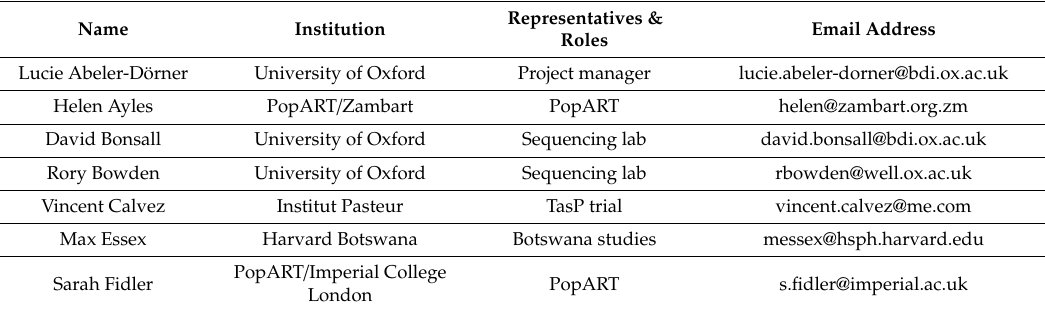
Table A1. PANGEA 2 Steering